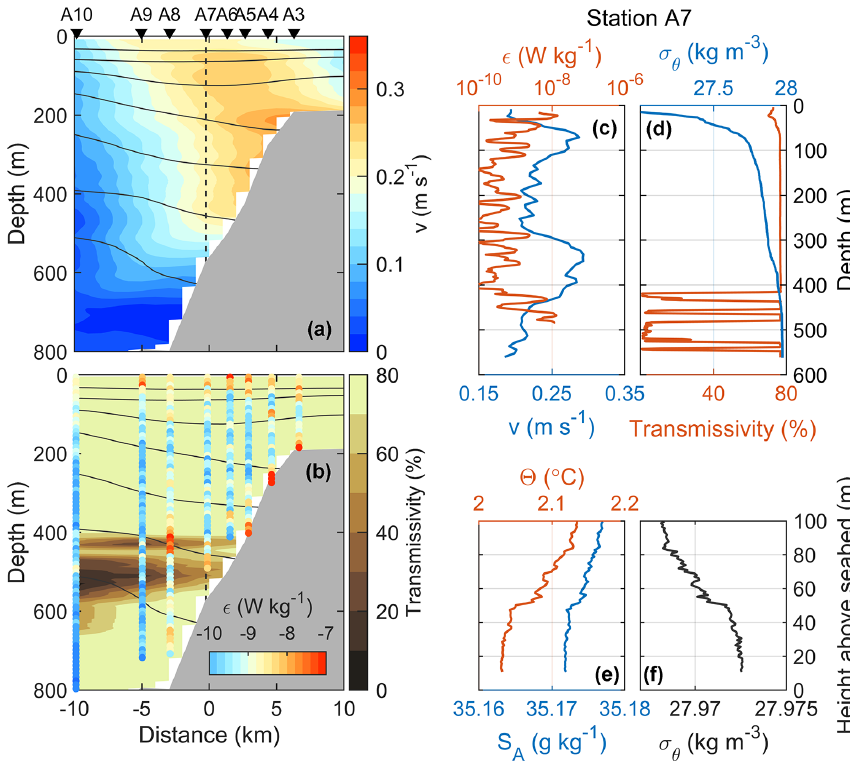
Figure 10. Same as Fig. 9 but for Section A and station